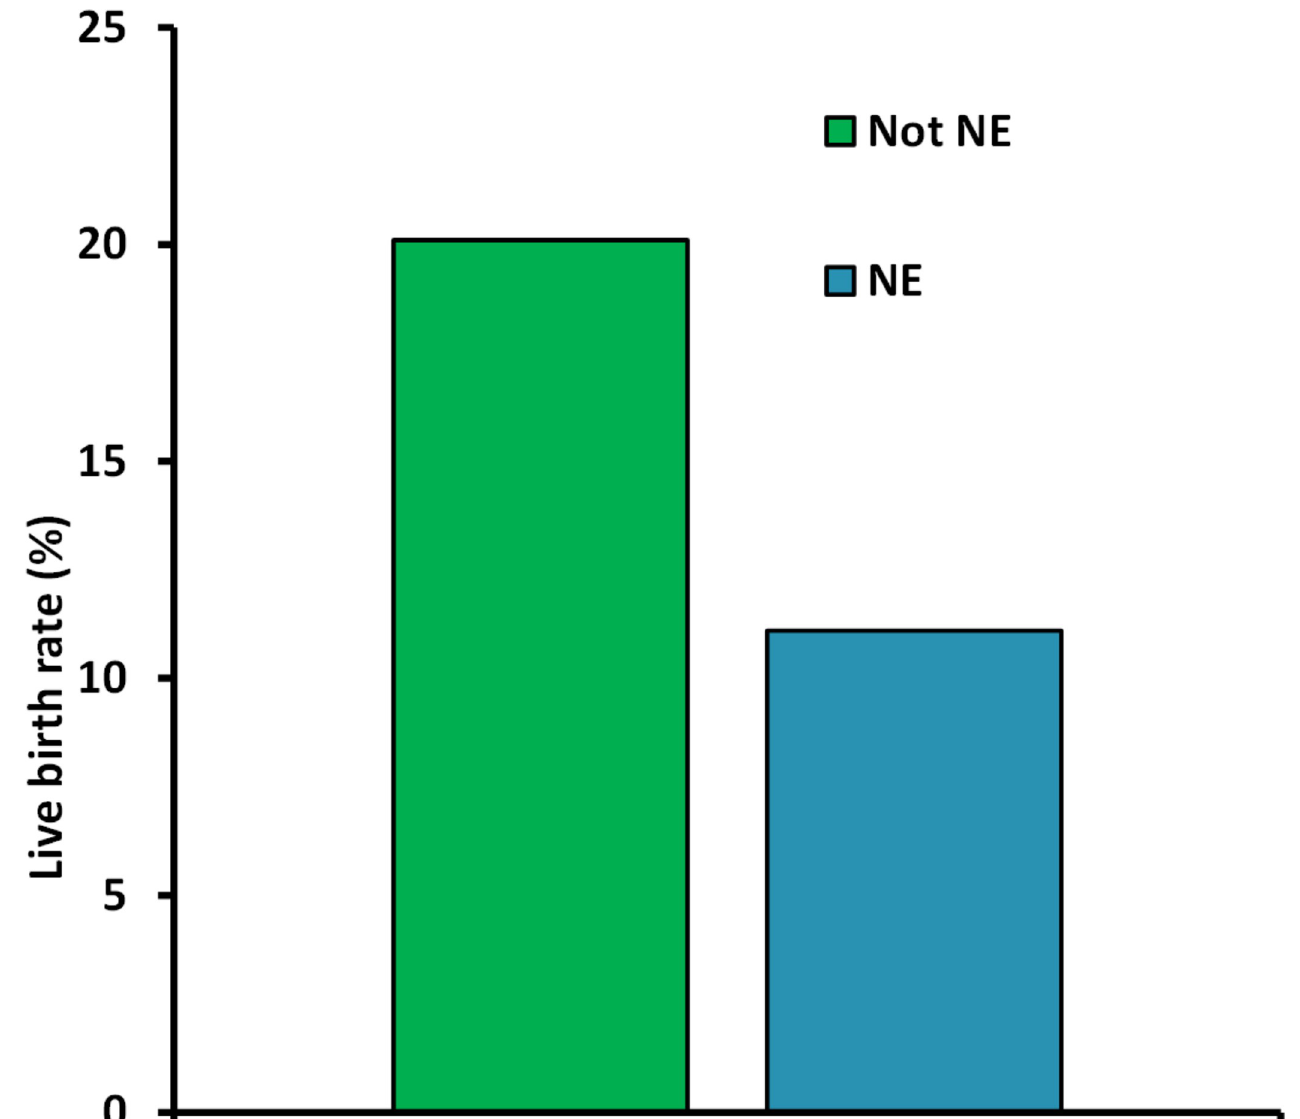
Fig 2. Live birth rate (LB) according to nuclear status of the transferred embryos. P < 0.001. between type of ovarian stimulation protocol (agonist or antagonist) and NE occurrence (23.4% vs. 24.0%; P = 0.5). Table 1). The NE occurrence is lower for day 2 transfers (OR = 0.74, P < 0.006; Table 2). Blastomere asymmetry. Uneven sized blastomeres at the 2-cell stage yields an OR for live birth of 0.55 (univariate) respectively 0.76 (multivariate). The associated P values are < 0.001 resp. 0.24. Hence, in this case the distinct statistical significance from a univariate analysis asymmetry is absent when considering several variables (covariates). When considering NE predictions for uneven sized blastomeres at the 2-cell stage (S3 Table), the OR is 1.62 (univariate) respectively 1.58 (multivariate). The associated P values are < 0.001 respectively > 0.003.